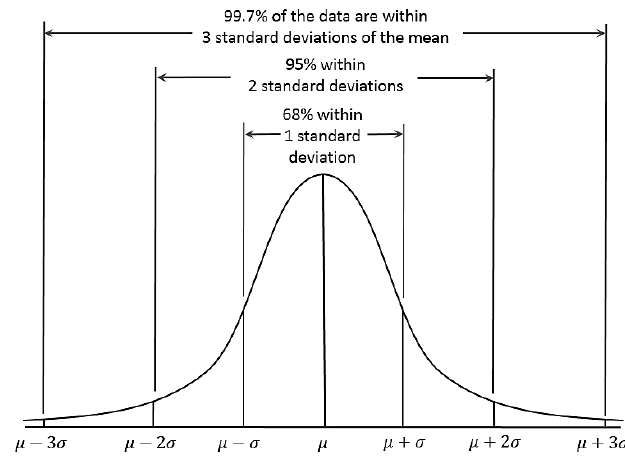
Figure 9. Concept of statistical anomaly detection, adapted from Internet minimum spanning tree with the cluster centres and remove the longest edge. The smaller sub trees are considered outliers. Their technique considers an entire cluster as an outlier, which may not be applicable for many datasets and may increase False Positive rate